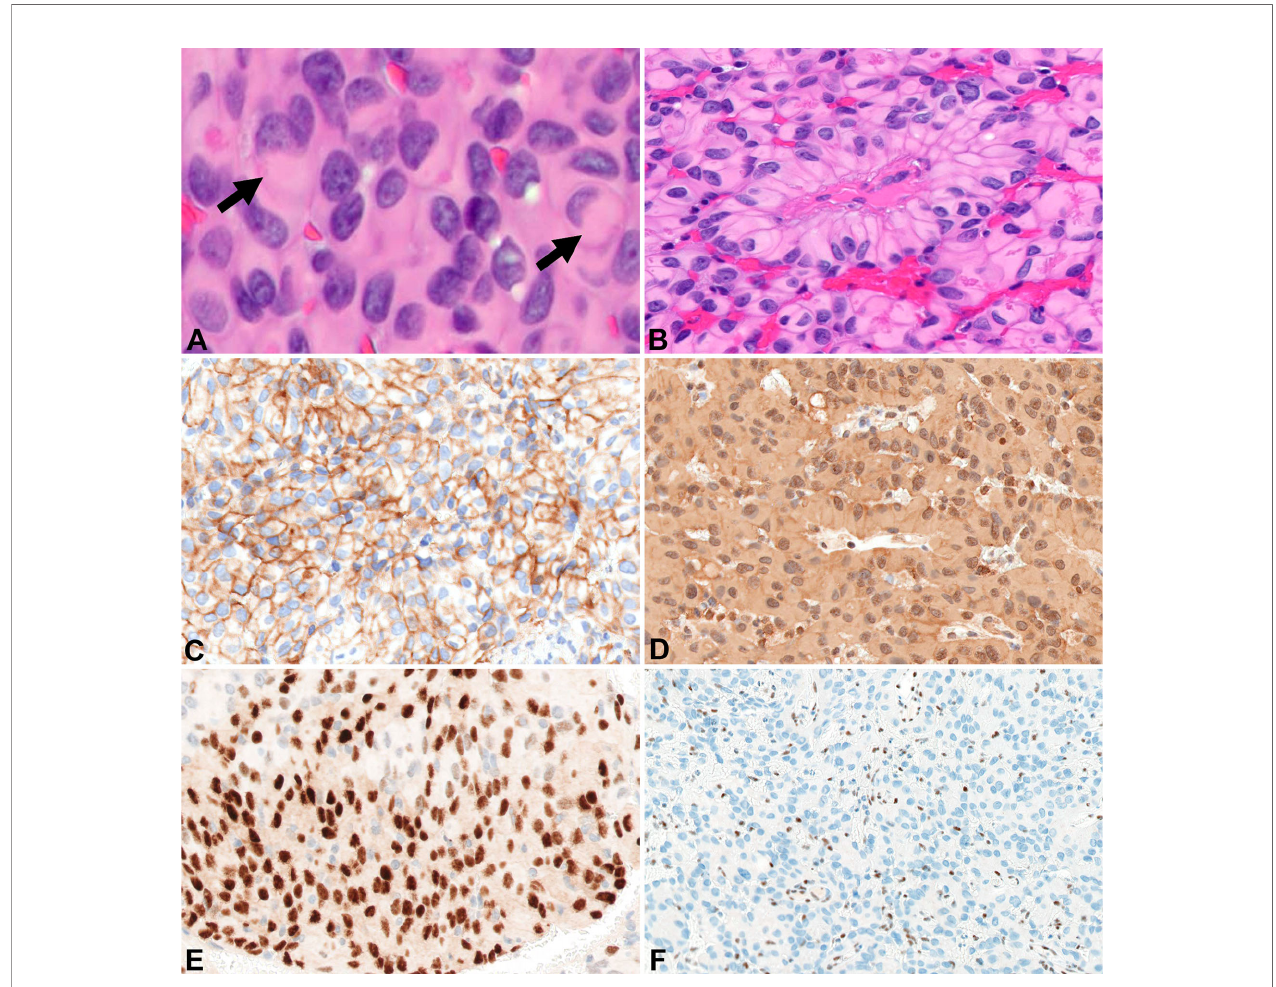
FIGURE 3 | Surgical pathology for Patient B H&E stained sections show areas of rhabdoid tumor cells with cytoplasmic hypereosinophilic inclusions (arrows) (400x) (A) . Papillary arrangement of tumor cells (200x) (B) . EMA highlights the tumor cells (200x) (C) . Tumor cells are diffusely positive for vimentin (200x) (D) . Focal immunoreactivity for progesterone receptor in the tumor cells (200x) (E) . Diffuse loss of BAP-1 immunoreactivity in the tumor cells with appropriate internal controls (100x) (F)